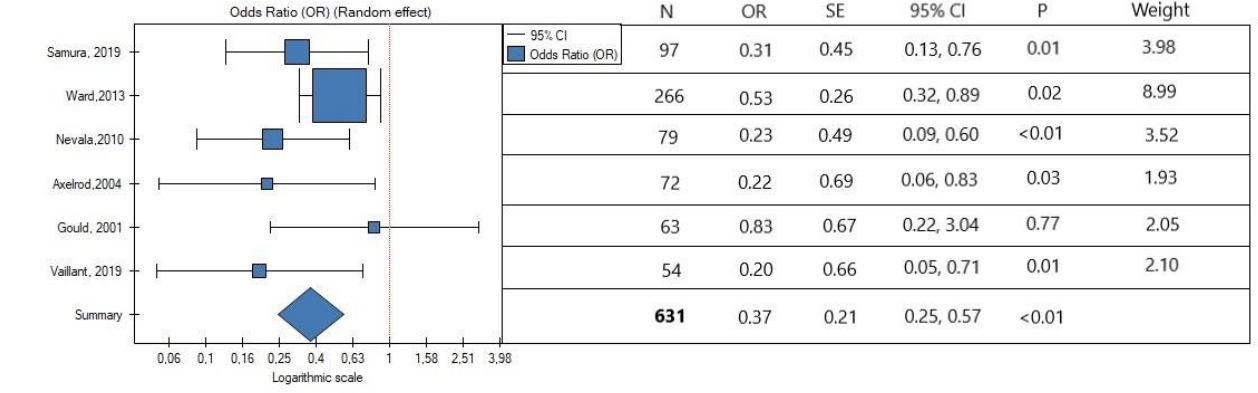
Figure 3. Association between IMA embolization and occurrence of endoleak type II. The horizontal line illustrates 95% confidence intervals (CIs). N, number of patients; OR, odds ratio; SE, standard error. Data referred from reference [22 – 27].